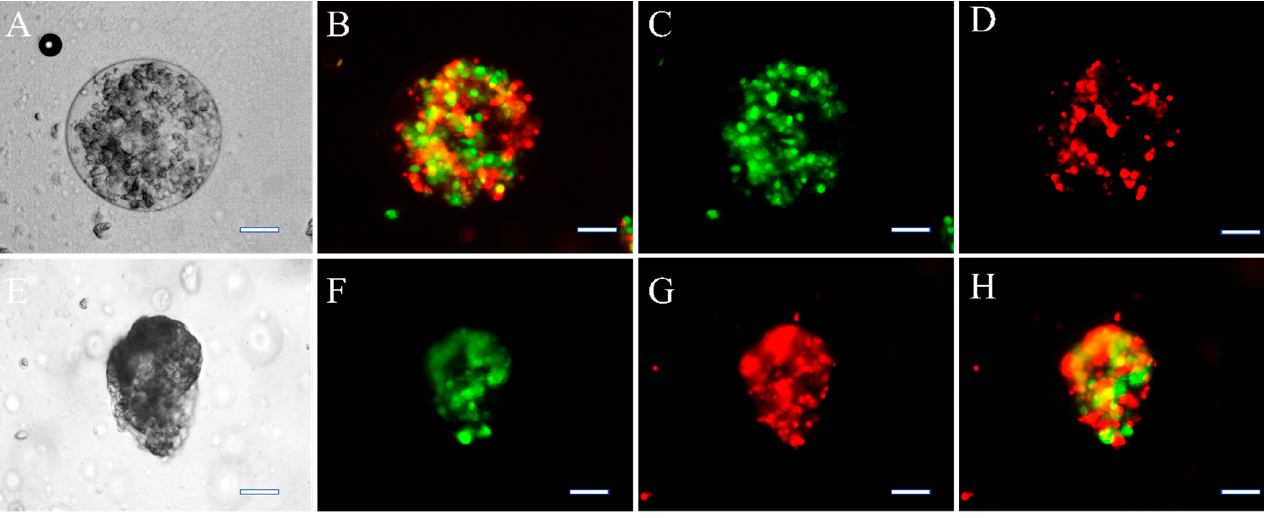
Figure 2. Bright-field ( A,E ) and fluorescence microscope observation of mixed Hep-G2 and HUVEC (cell ratio = 5:1) cells encapsulated by 5.5 wt% DEX in 5.5 wt% PEO emulsions before ( A – D ) and after shrinking by 11 wt% PEO ( E – H ) set at FITC ( B,F ), CFSE far-red set at TRITC ( C,G ), and dual fluorescence FITC and TRITC channels ( D,H ). Clusteroids in the emulsions ( A – D ) and clusteroids taken out from the emulsions ( E – H ) were taken for imaging immediately after their formation. The Hep-G2 cells and HUVEC cells were pre-stained with CFSE and CFSE far-red, respectively. The bar is 50 μ m.